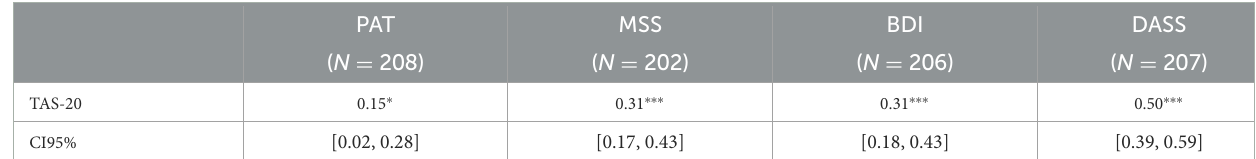
TABLE 8 Correlation of the TAS 20 with psychometric test